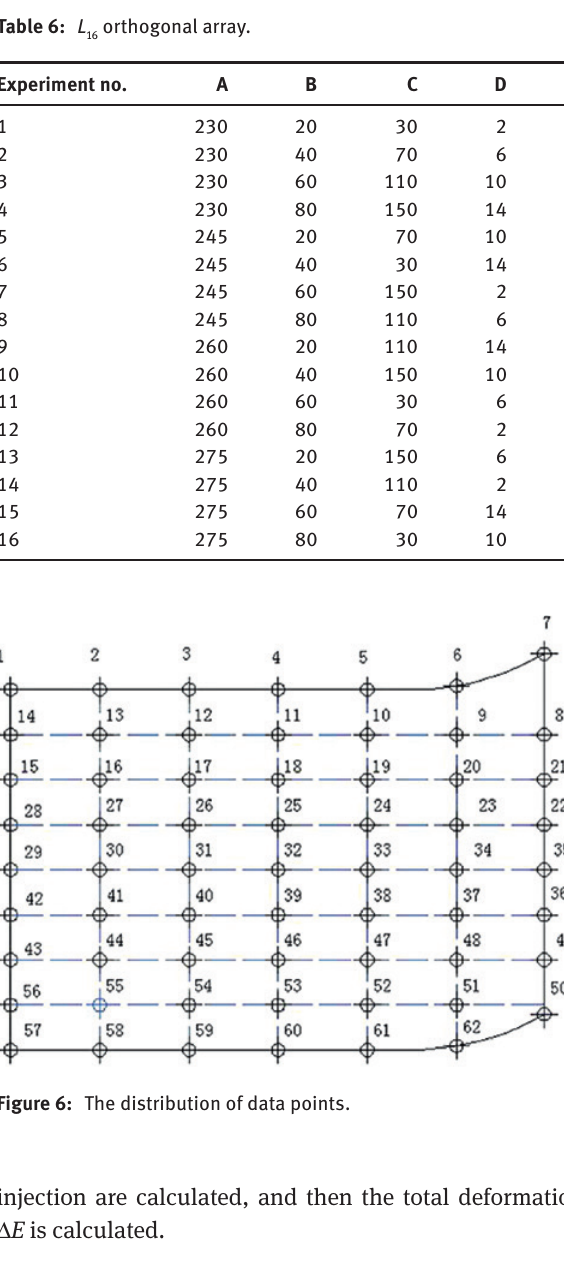
injection are calculated, and then the total deformation Δ E is